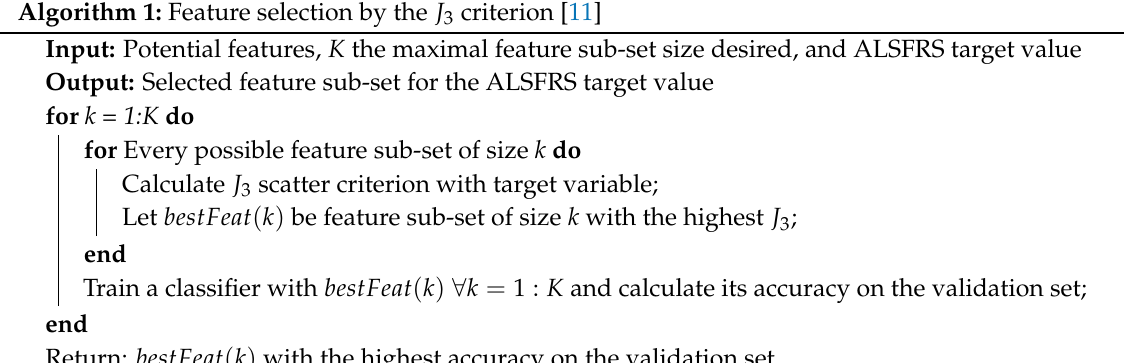
Algorithm 1: Feature selection by the J 3 criterion